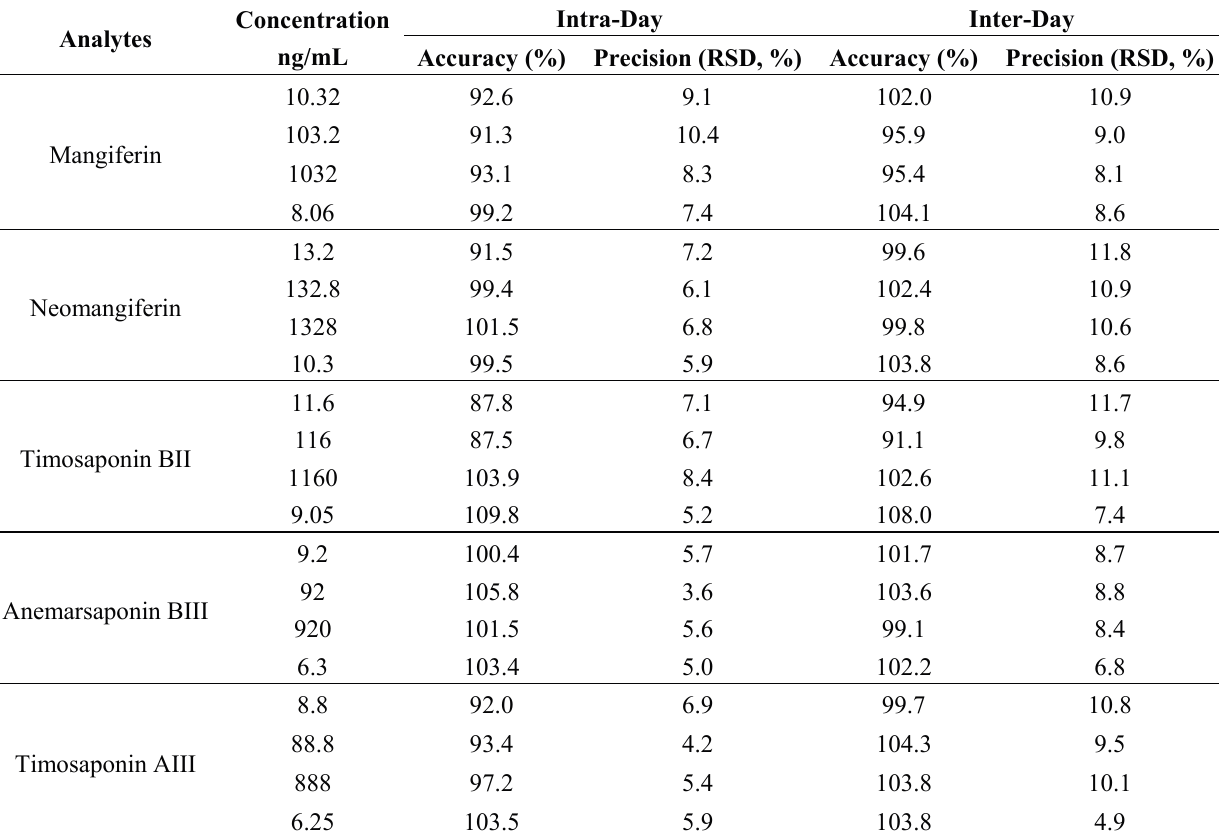
Table 1. The accuracy and intra- and inter- day precision of five analytes in rat plasma (n = 5). Intra-Day Inter-Day Concentration Analytes ng/mL Accuracy (%) Precision (RSD, %) Accuracy (%) Precision (RSD, %) Mangiferin